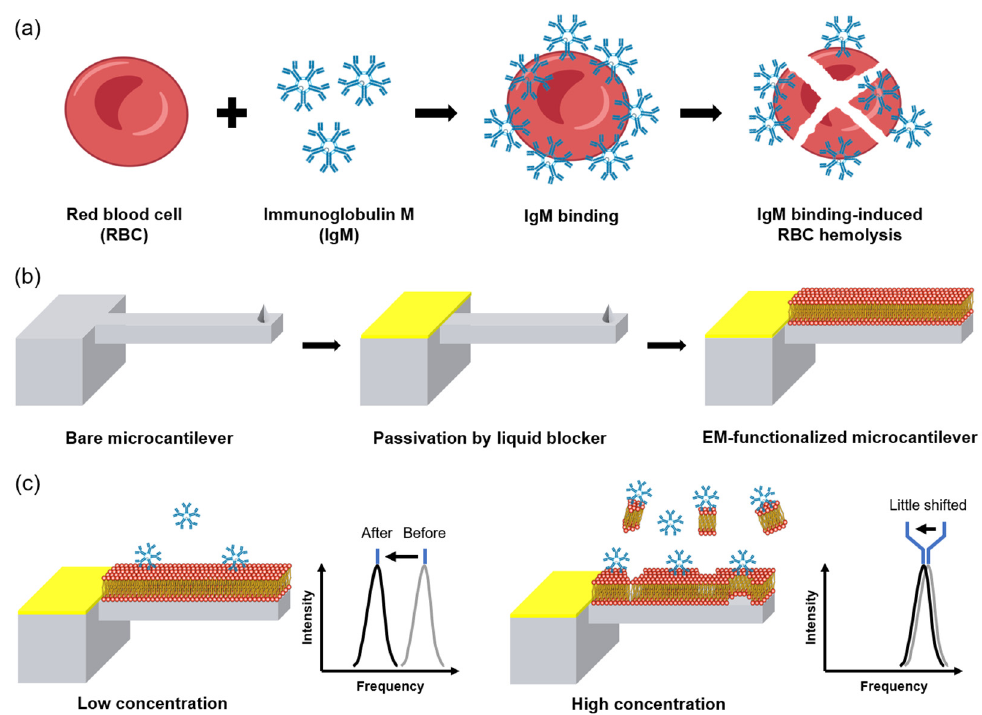
Figure 1. Schematic illustration of ( a ) hemolysis of erythrocyte due to high concentration of IgM and ( b ) the EMMC fabrication process. The base and MC are shown in gray, the liquid blocker in yellow, and the EM in red. ( c ) EMMC illustration and Δ ω at low and high concentrations of IgM.